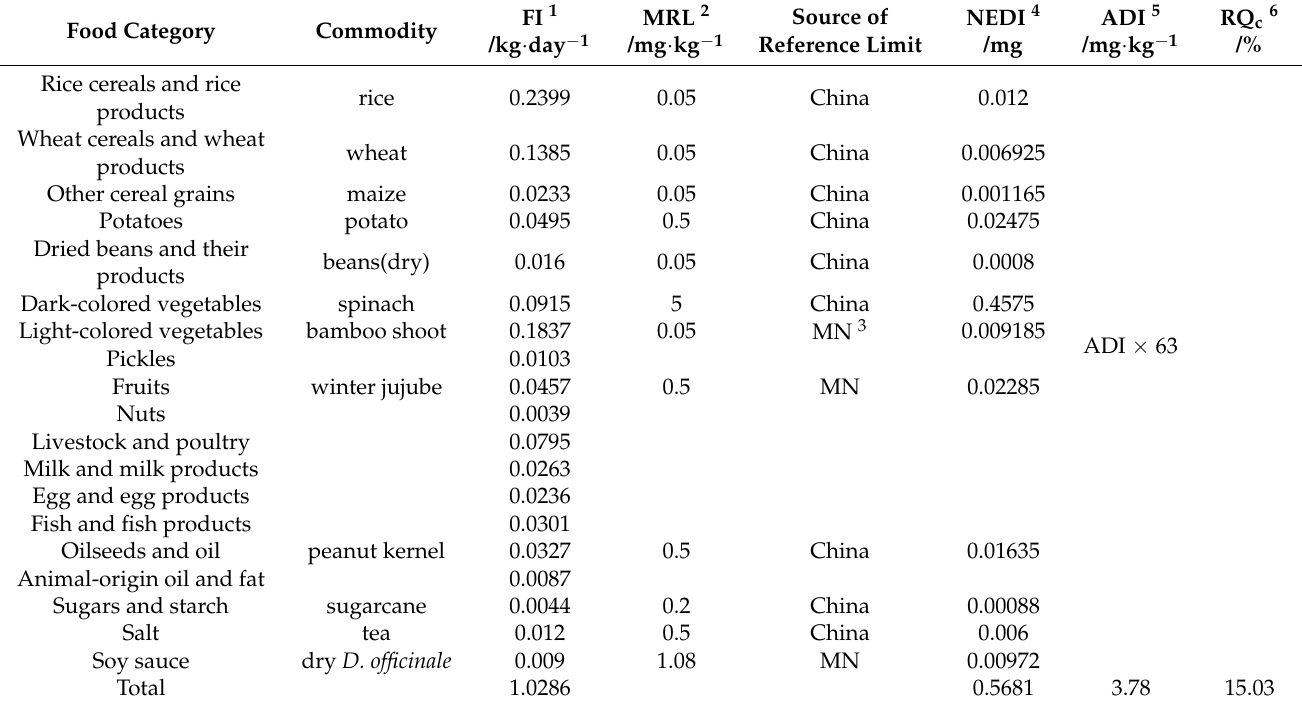
Table 4. The long-term dietary risk assessment of imidacloprid in different